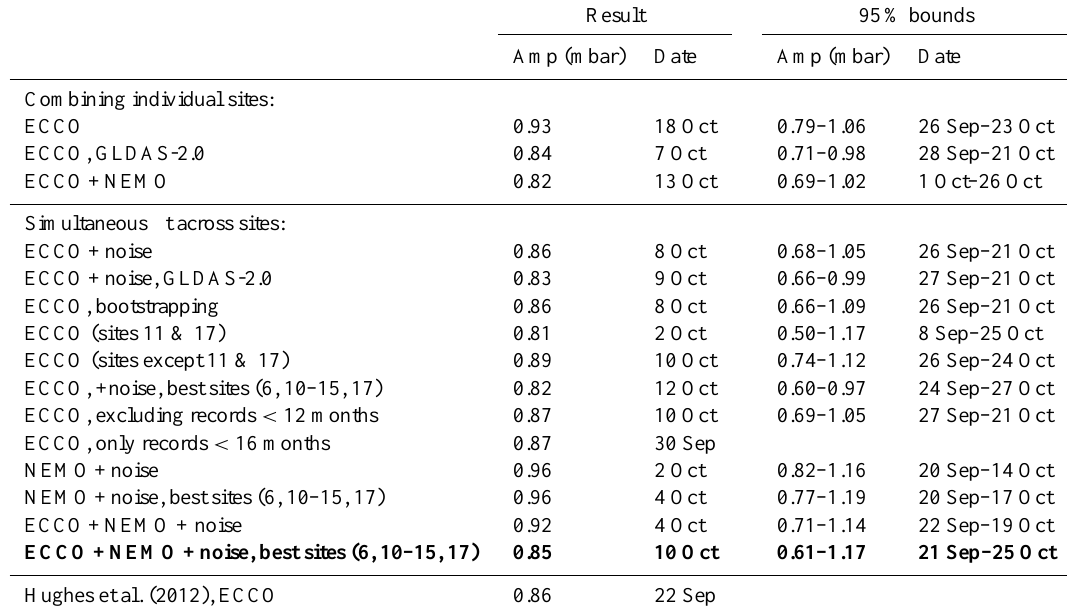
Table 2. Summary of results for ocean mass. Summary of results for ocean mass. Our best estimate is highlighted in